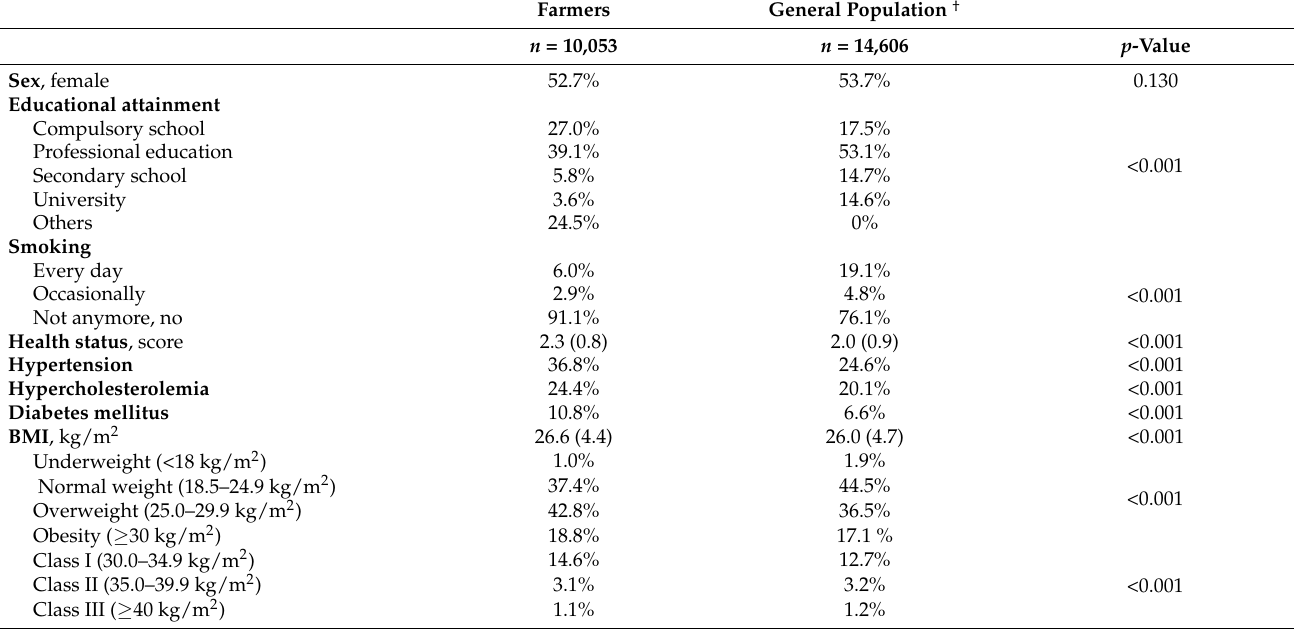
Table 1. Characteristics of farmers in comparison to the general